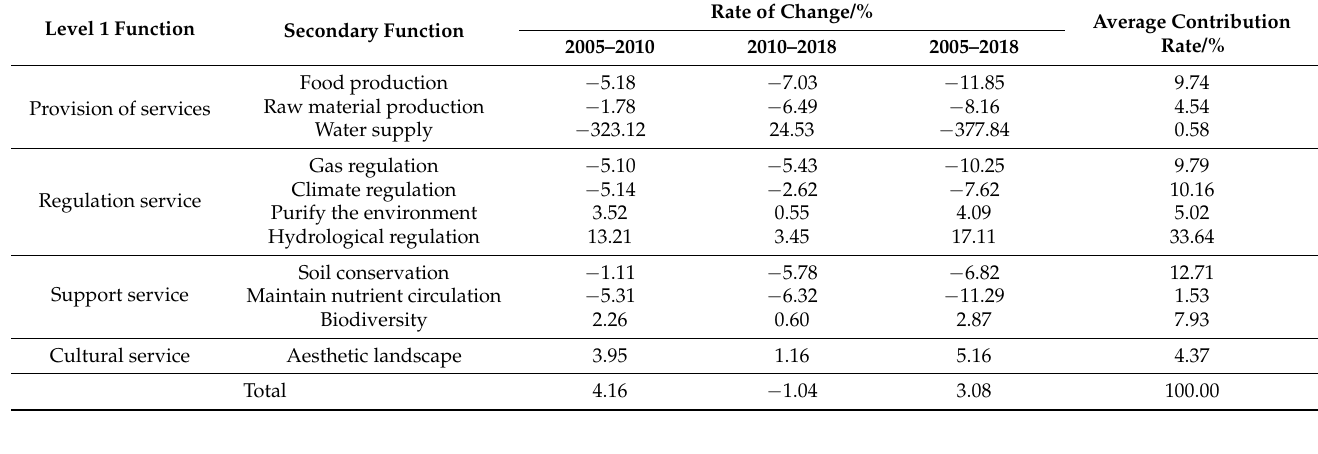
Table 6. The number and proportion of different grading zones of ESV.